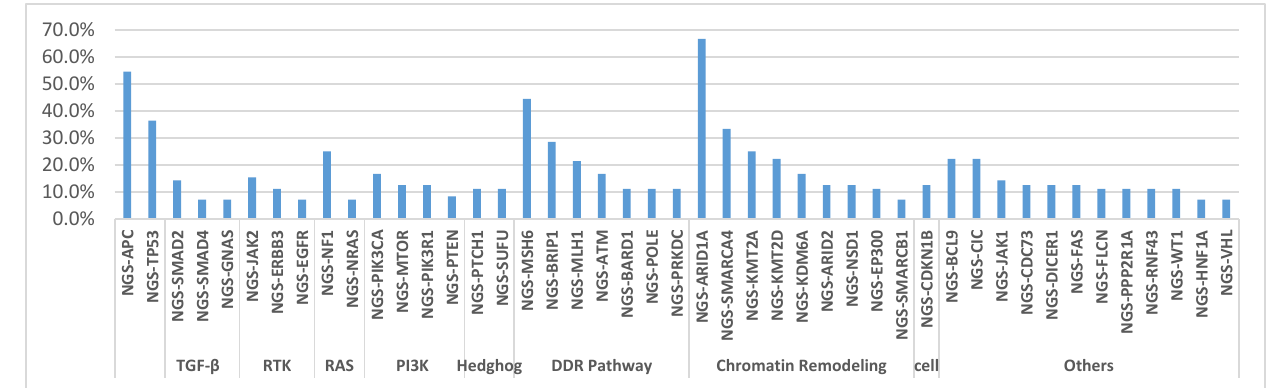
Figure 2. List of the most prevalent comutated genes in KRAS A59T mutant CRC tumors, categorized by pathway or role. Table 3. List of identified prevalent mutations co-occurring with KRAS A59T mutations in CRC, sorted in the context of molecular pathways.